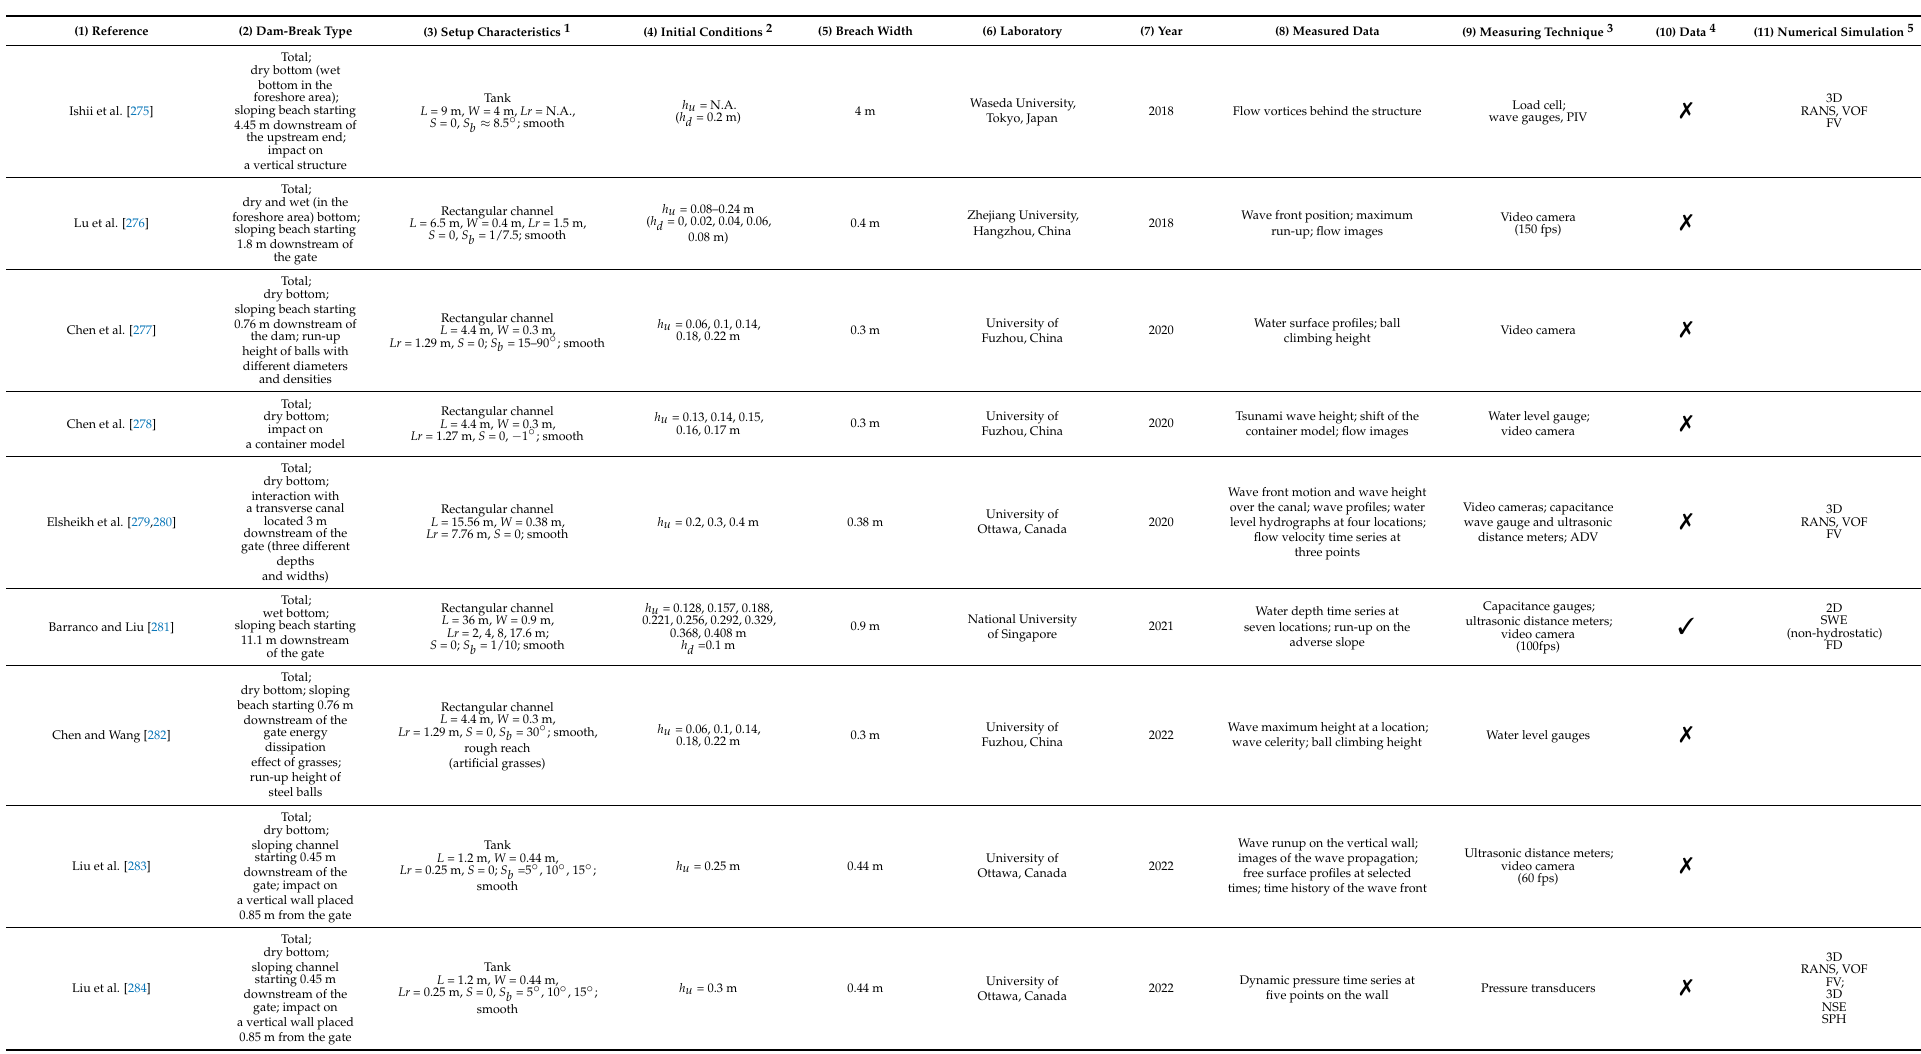
Table 1. Basic experimental investigations of fundamental dam-break wave physical characteristics.